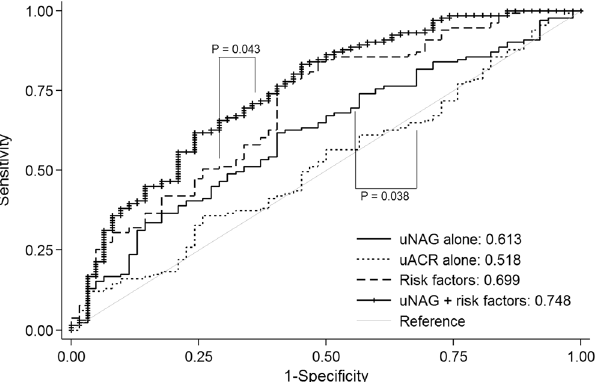
Figure 2. Measurement of uNAG improved the identification of subjects with higher G/A ratios, in addition to conventional risk factors such as uACR. The solid line, very short dash line, dash line, and line with small cross represent the discriminatory ability characterized by the area under the curve (AUC) for log-uNAG alone, log-uACR alone, for the model that included conventional risk factors (log-uACR, age, sex, BMI, diabetes duration, angiotensin blocker use, eGFR, and fasting plasma glucose level), and for the composite of log-uNAG and the conventional risk model, respectively. Abbreviations: log-uNAG, log-transformed urinary N-acetyl- β -D-glucosaminidase; log-uACR, log-transformed urinary albumin-to-creatinine ratio; ROC, receiver operating characteristics curve; BMI, body mass index; eGFR, estimated glomerular filtration rate; G/A ratio, glycoalbumin-to-hemoglobin A1c